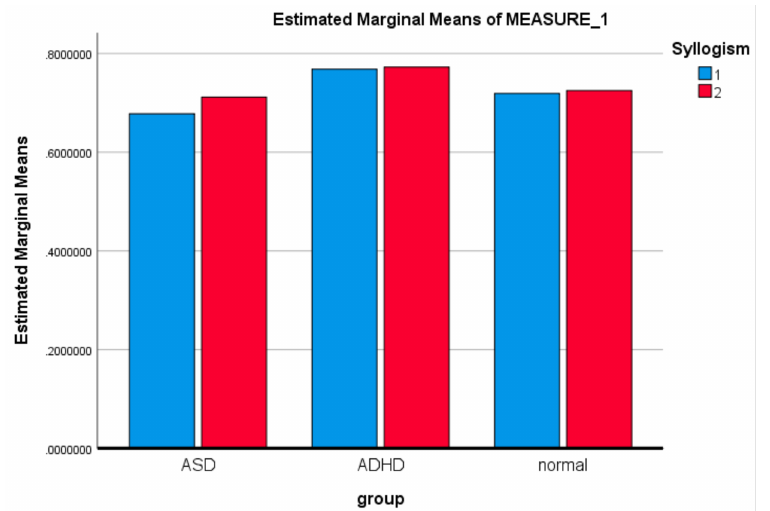
Figure 6. Marginal means of complexity (MSE), for each group of participants for valid and invalid syllogisms. When passing from valid to invalid cognitive load in the ASD group, the complexity increases.